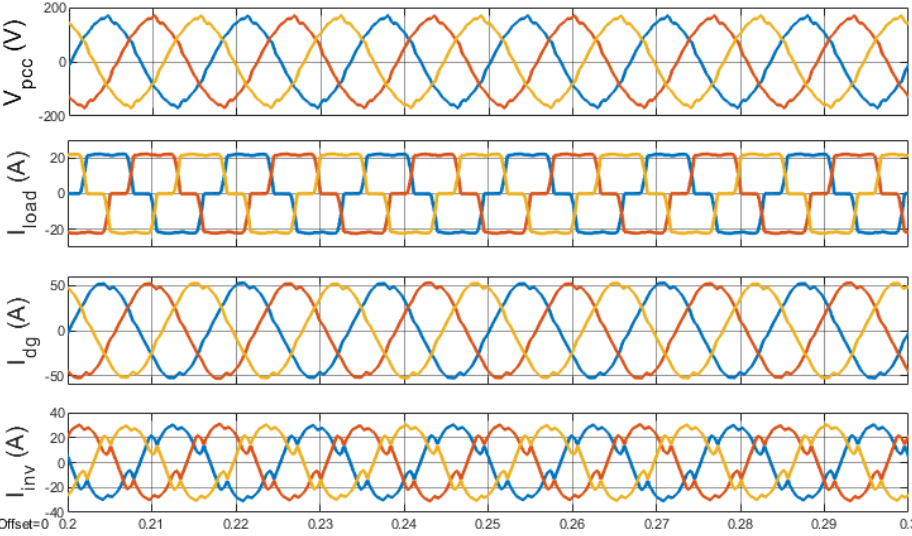
Figure 9. Zoom from Figure 5 between t = 0.2 s and t = 0.3 s.